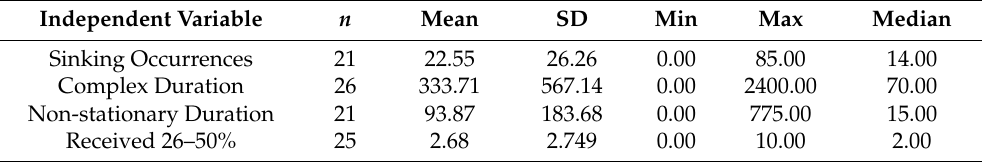
Table 4. Descriptive statistics for independent variables included in the multivariable modeling process.